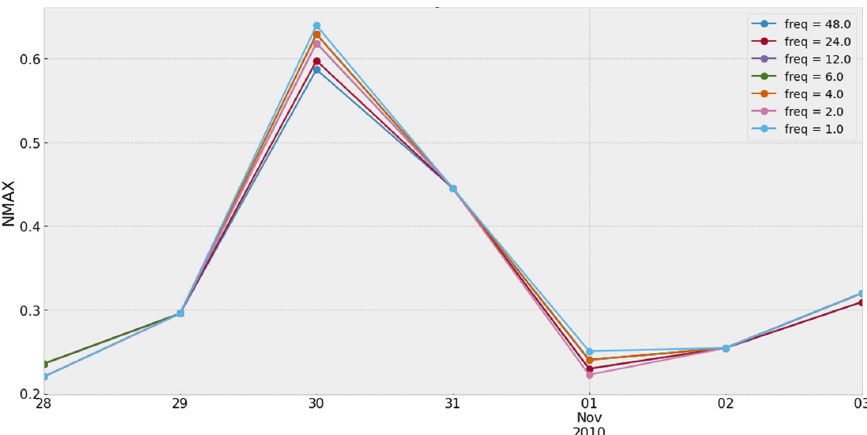
Figure 5. Daily normalized maximum error (NMAX) of GEPP on a sample week for different daily forecasting frequencies in Scenario 1.